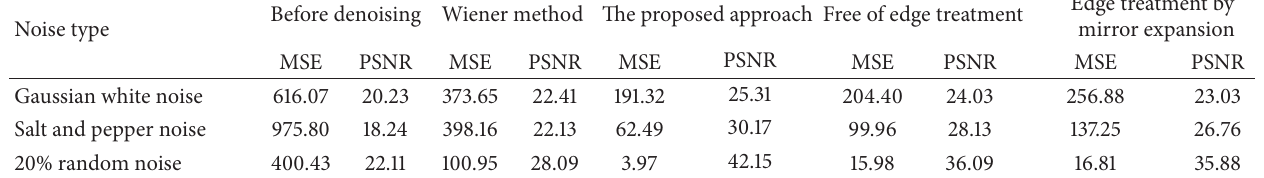
Table 1: Peak signal to noise ratios (PSNRs) of the noisy and denoising images. Noise type